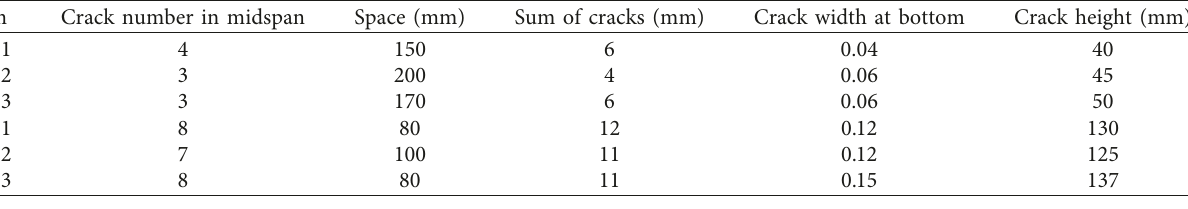
Table 2: Parameters of initial cracks on the midspan.